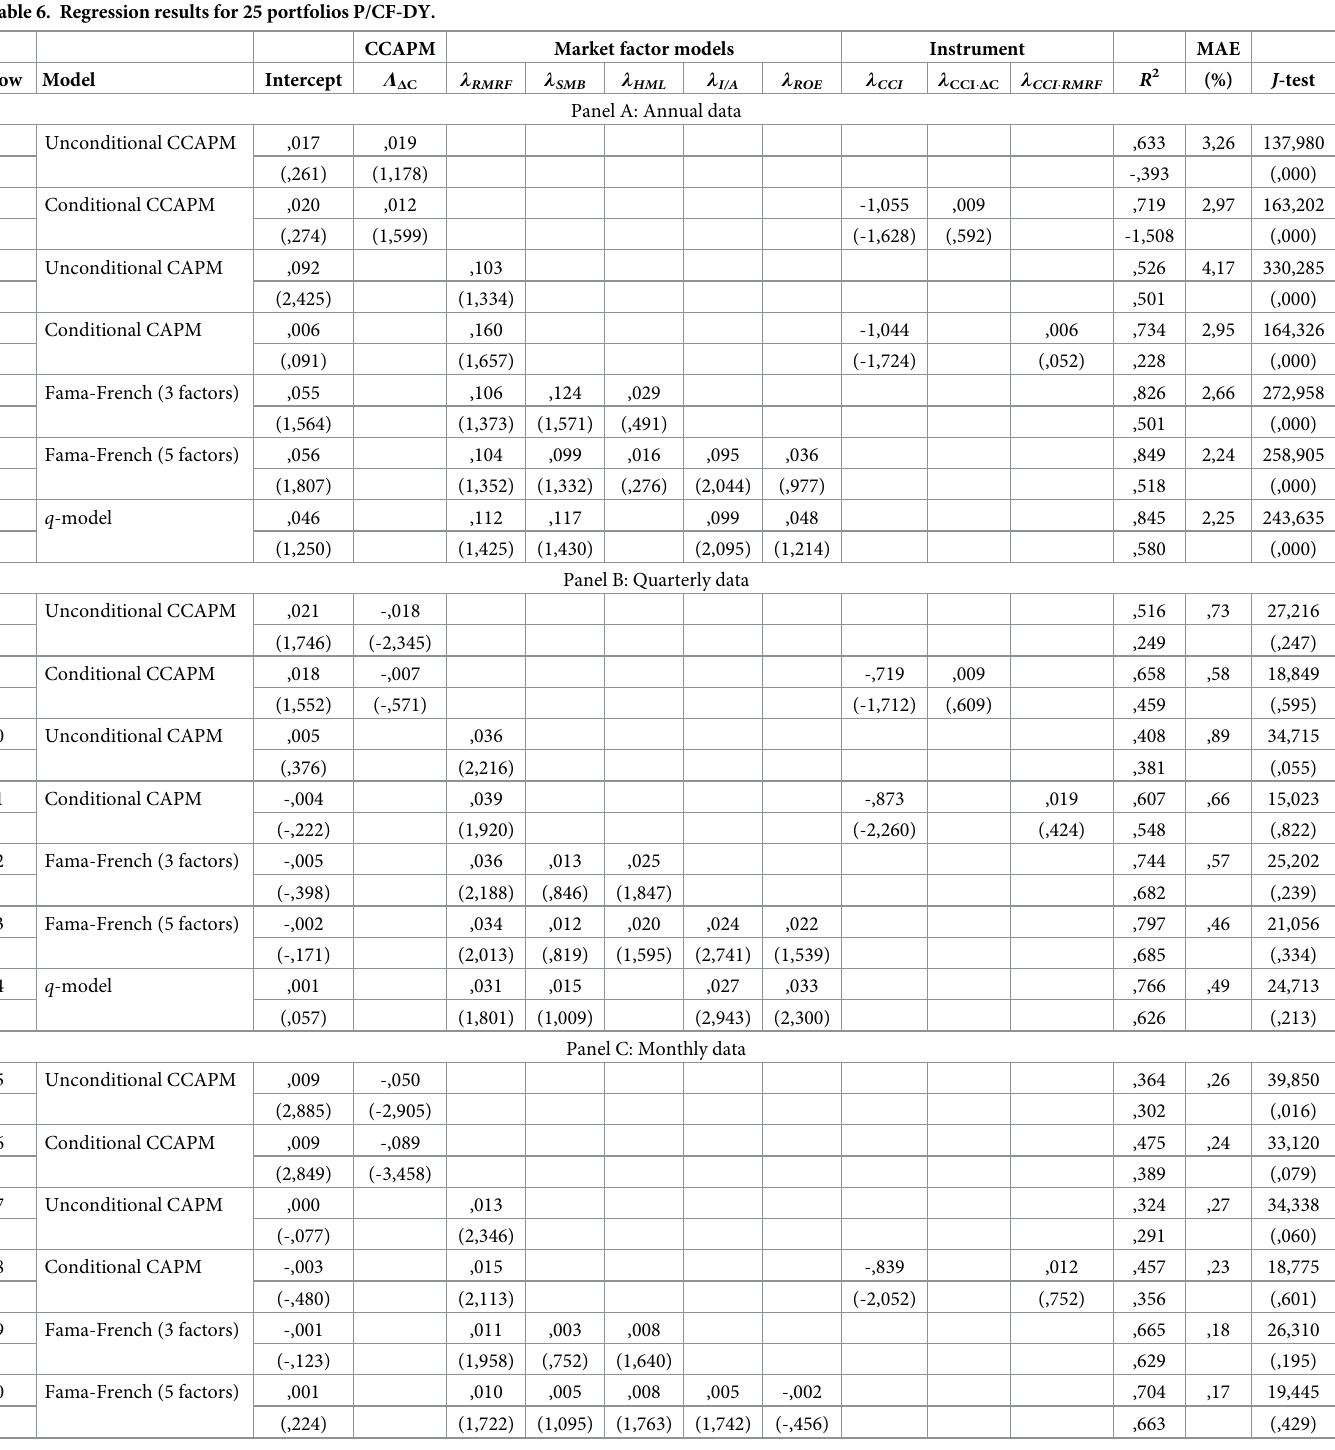
Table 6. Regression results for 25 portfolios